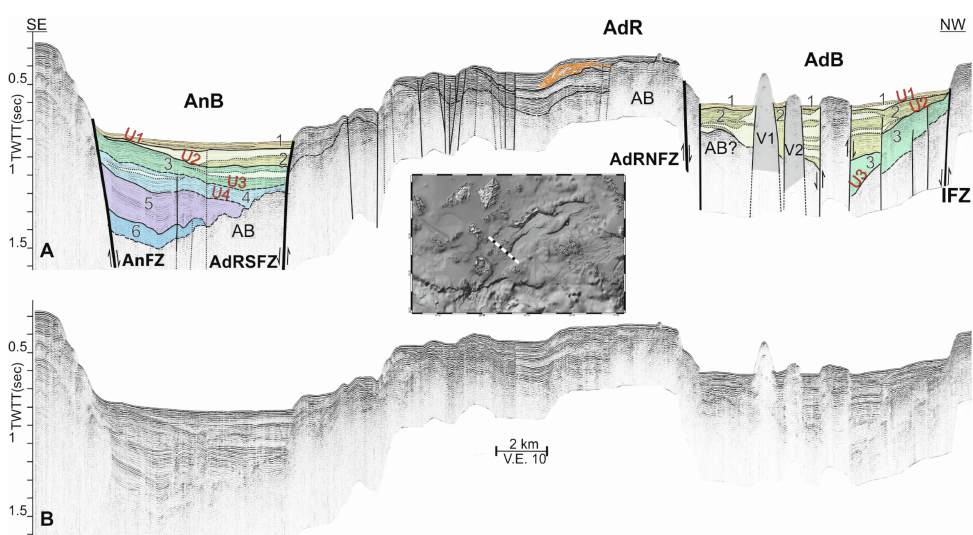
Figure 4. Air gun 40 ci seismic profile crossing the western part of Anydros Basin (AdB), Anydros Ridge (AdR), and Anafi Basin (AnB). The numbers 1 to 6 represent the six seismic units described in the text. U1, U2, U3, and U4 correspond to the observed, major unconformities. AB: Acoustic Basement, AdRNFZ: Anydros Ridge North Fault Zone, AdRSFZ: Anydros Ridge South Fault Zone,